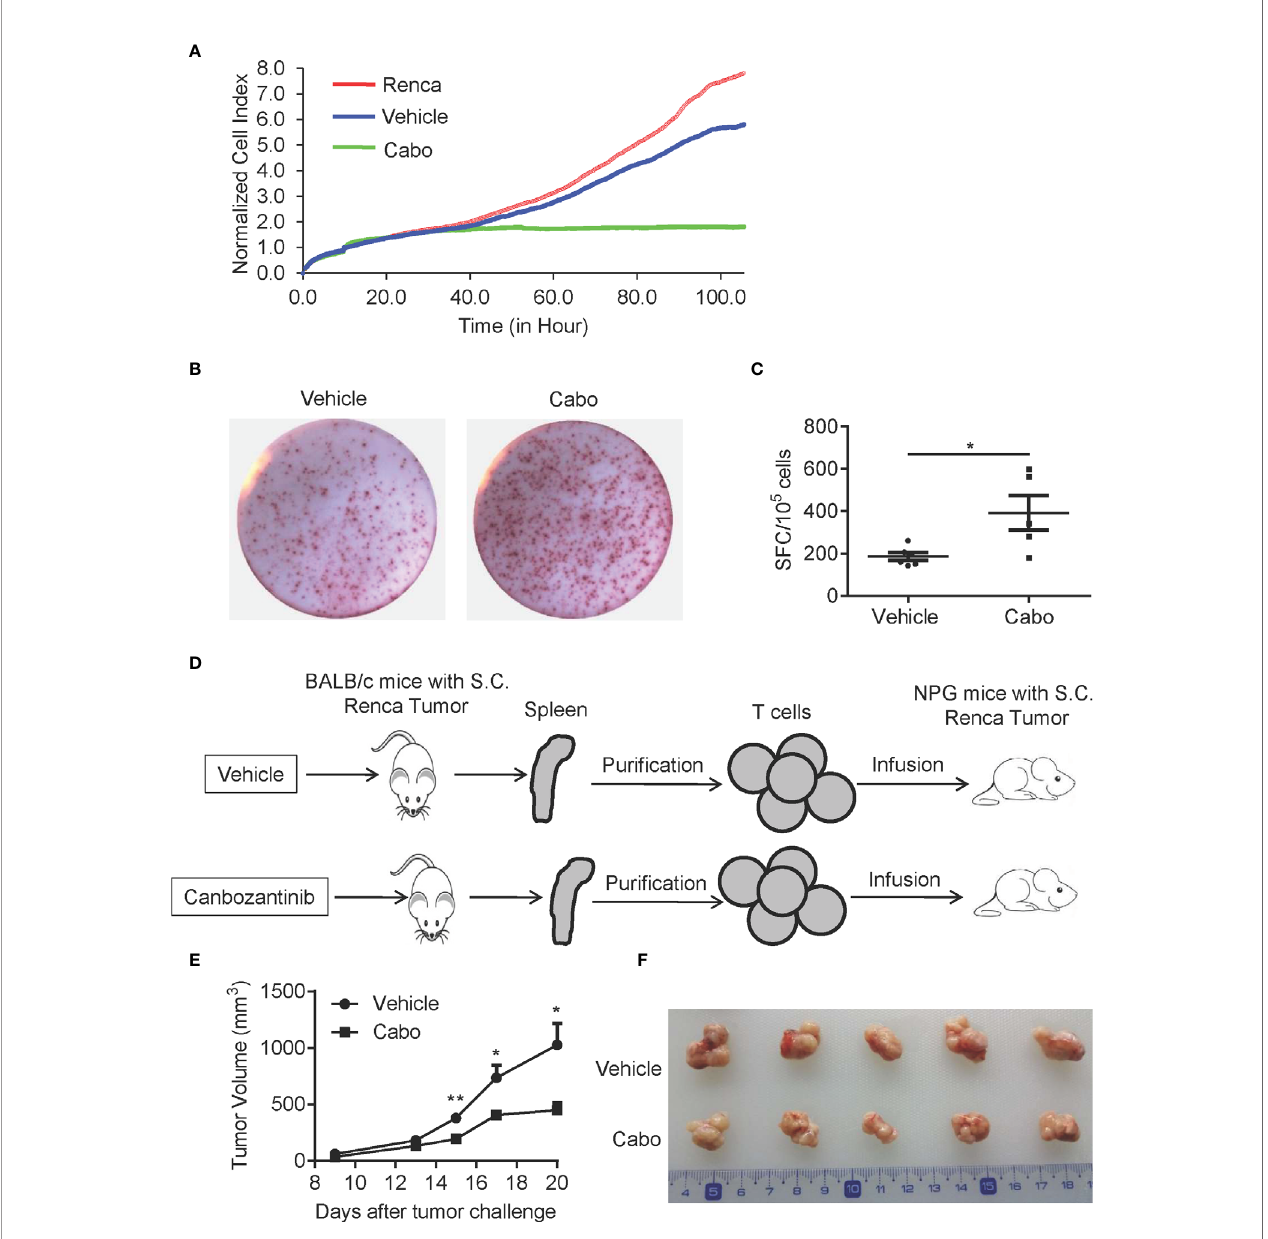
FIGURE 7 | Cabozantinib treatment enhances the anti-tumor effects of T cells. (A) T cells were isolated from tumors of BALB/c mice that received vehicle or cabozantinib treatment as in Figure 2A and were cocultured with Renca cells at a ratio of E:T=2:1. The cytotoxicity of T cells was measured by RTCA (n=3 for biological replicate). (B, C) Representative plots and quantitative results of IFN- g production by splenic T cells by ELISPOT assay. T cells were puri fi ed from splenocytes and were then stimulated with PMA (500 ng/ml) and ionomycin (10 m g/ml). IFN- g spots were analyzed (n=3 for biological replicate). (D) Schematic diagram of the experimental design. T cells isolated from vehicle or cabozantinib treated tumor bearing BALB/c mice were adoptively transferred to NPG mice with palpable RCC tumors. (E) Tumor growth curves of NPG mice receiving T cells from different sources (n=5 per group). (F) Representative tumor images from different treatment groups. These experiments were repeated 2 times. * P <0.05, ** P <0.01 by unpaired